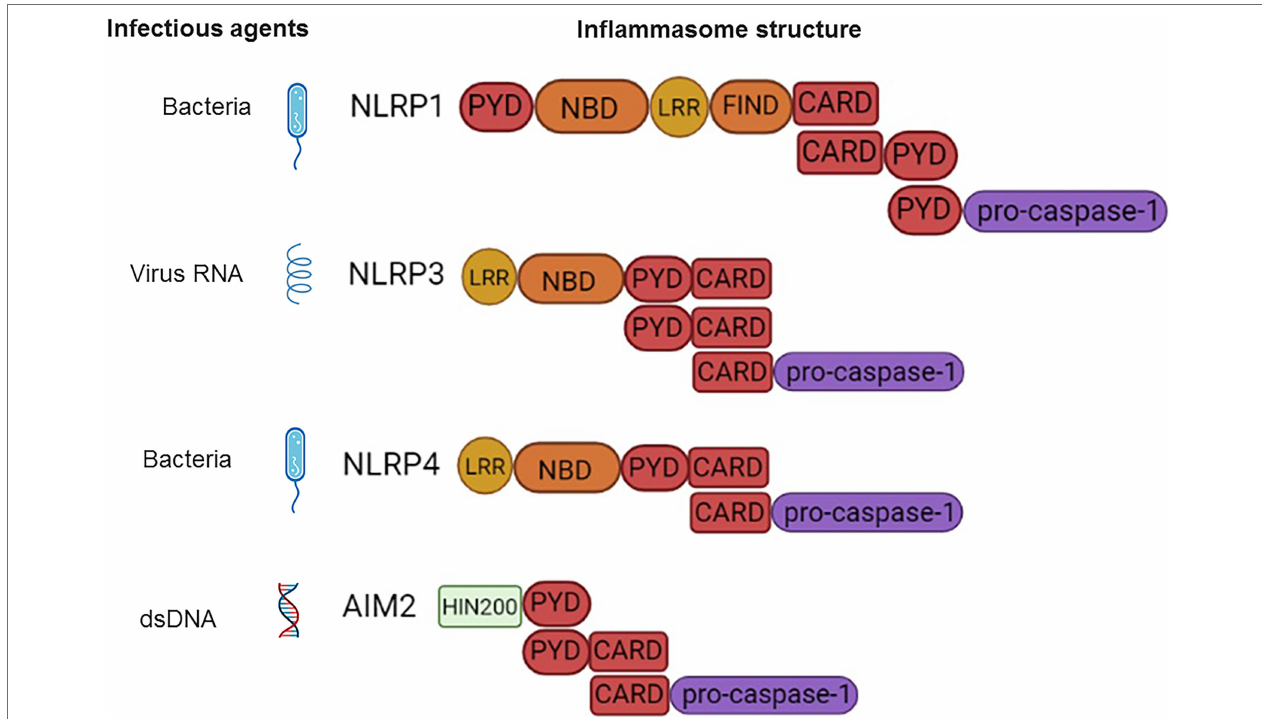
FIGURE 1 | Schematic presentation of the inflammasome structure and pathogen-associated molecular patterns (PAMPs) ligands. NLRP1-CARD binds to and forms a dimer with CARD of pro-caspase-1. NLRP3-CARD-PYD polymerizes with adaptor ASC (PYD-CARD). This is followed by CARD dimerization with CARD- pro-caspase-1. NLRC4-CARD forms a dimer with CARD of ASC (PYD-CARD) adaptor. The PYD of ASC then polymerizes with PYD of the second ASC adaptor molecule. This second ASC CARD binds to CARD of pro-caspase-1. AIM2-PYD dimerizes with PYD of ASC (PYD-CARD), followed by CARD of ASC binding to